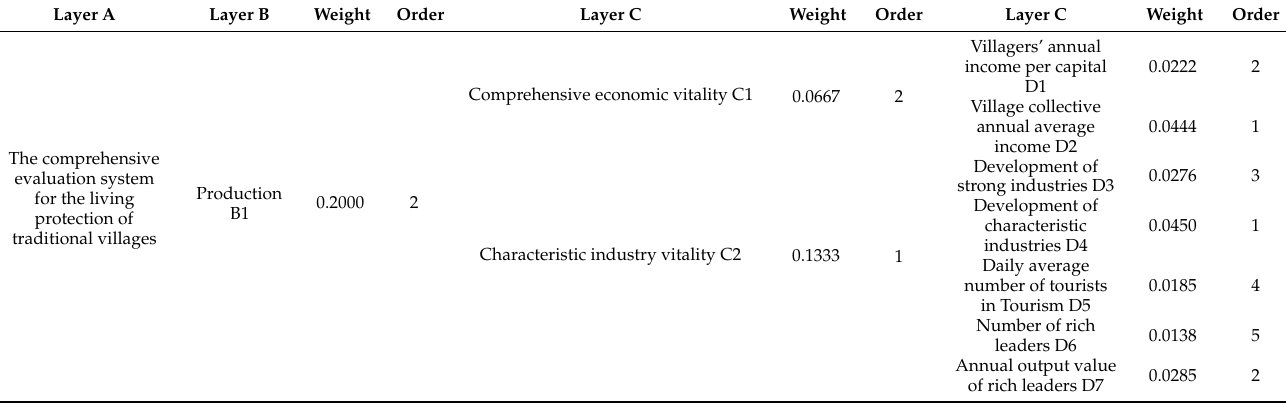
Table A1. The comprehensive evaluation system for the living protection of traditional villages. Layer